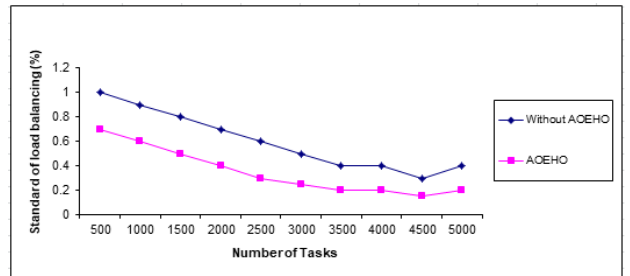
Figure 16. Standard of load balancing.